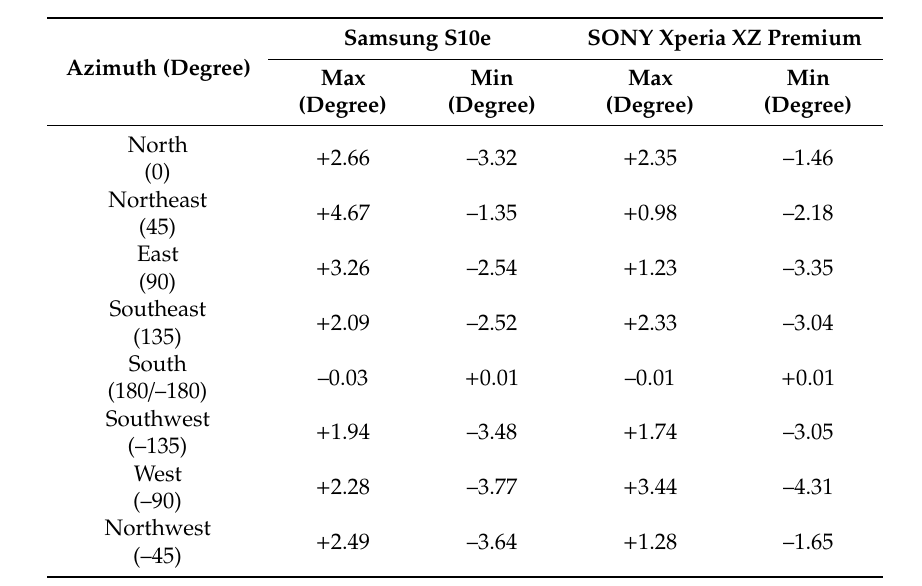
Table 2. The accuracy of